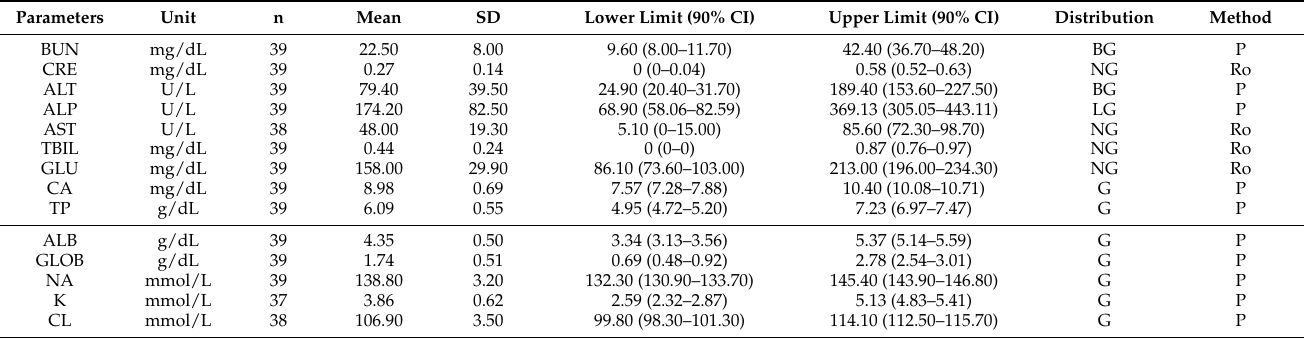
Table 3. Plasma biochemical reference intervals of pet sugar gliders in